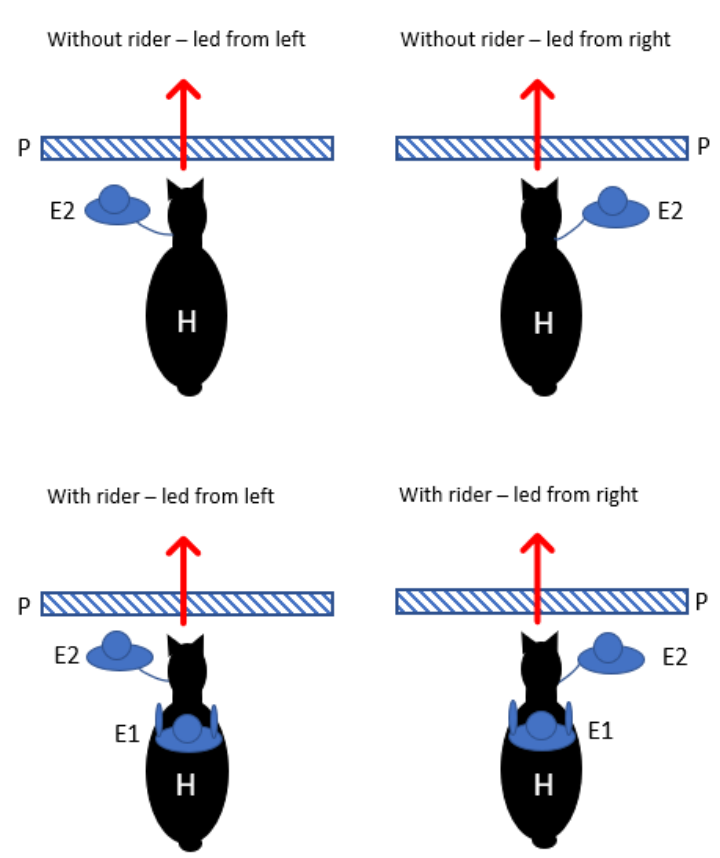
Figure 2. Setup for motor laterality foreleg preference test. The four variations of the foreleg preference test showing the horse (H) being led by Experimenter 2 (E2) from the left or right side, either with or without a rider (E1). The arrow indicates the direction of the horse (H) and Experimenter 2 (E2) stepping over the pole (P) on the ground.